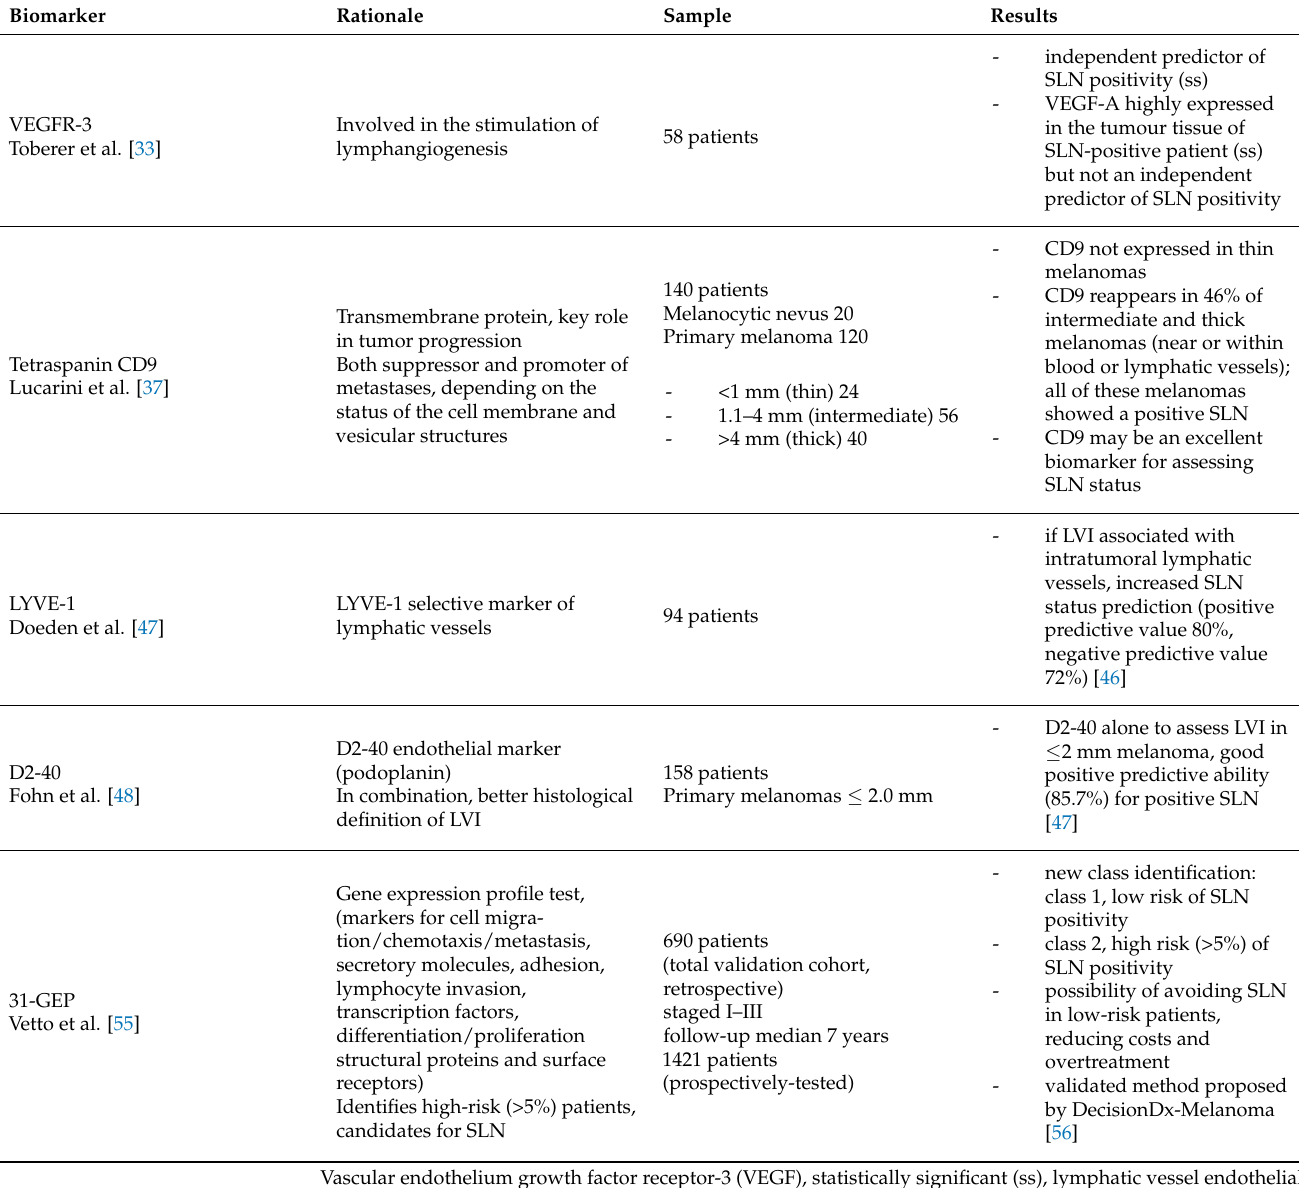
Table 2. summary of reviewed biomarkers for SLN